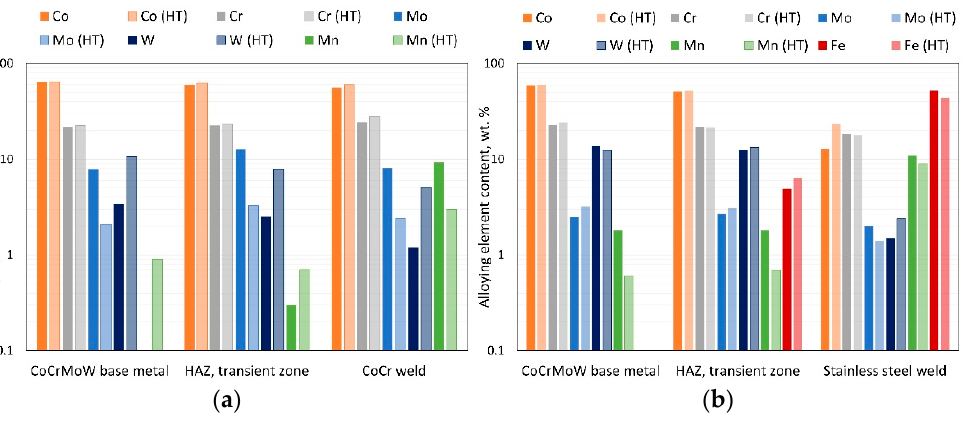
Figure 9. Comparison of the main alloying elements in the welded joints, as follows: ( a ) CoCrMoW welded with CoCr wire, ( b ) CoCrMoW welded with stainless steel wire.